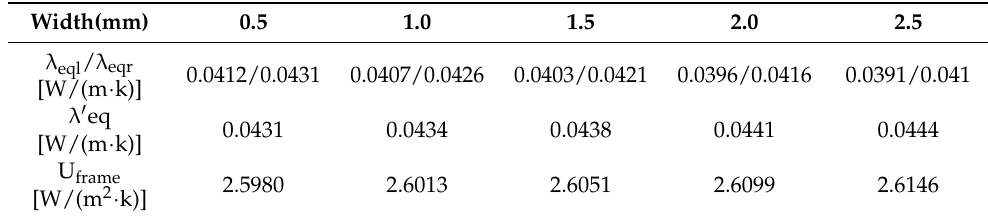
Figure 8. Effect of RIP width on window frame. Table 4. Effect of RIP width on heat transfer from window